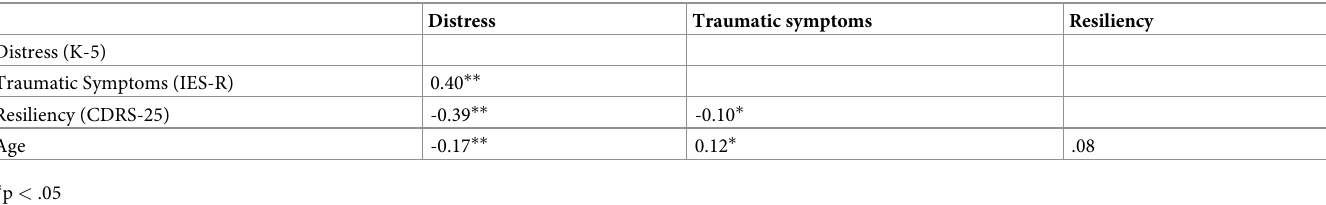
Table 2. Correlations of mental health scales and age. Correlations between mental health scales and age of participants with significance